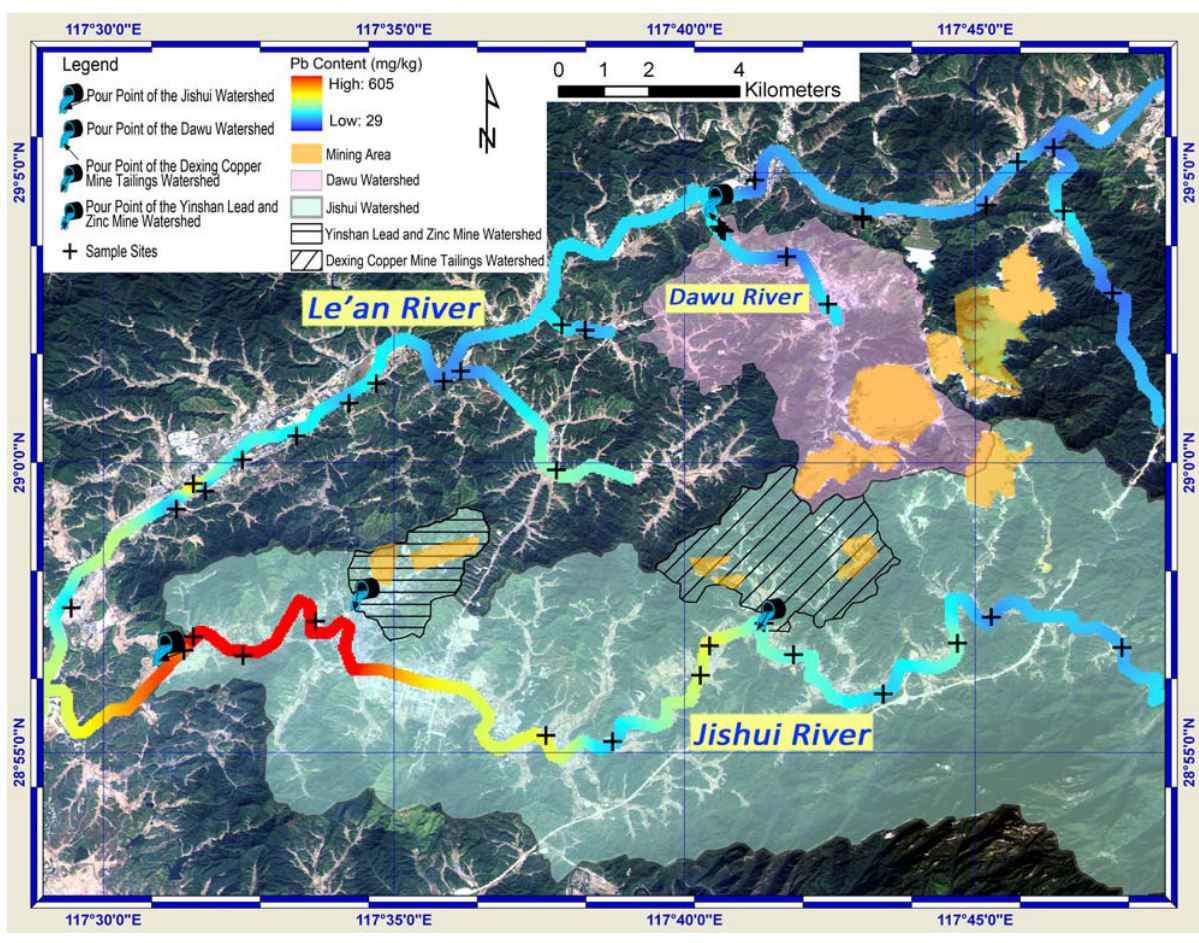
Figure 8. Spatial relationships between watersheds, mining area and total Pb